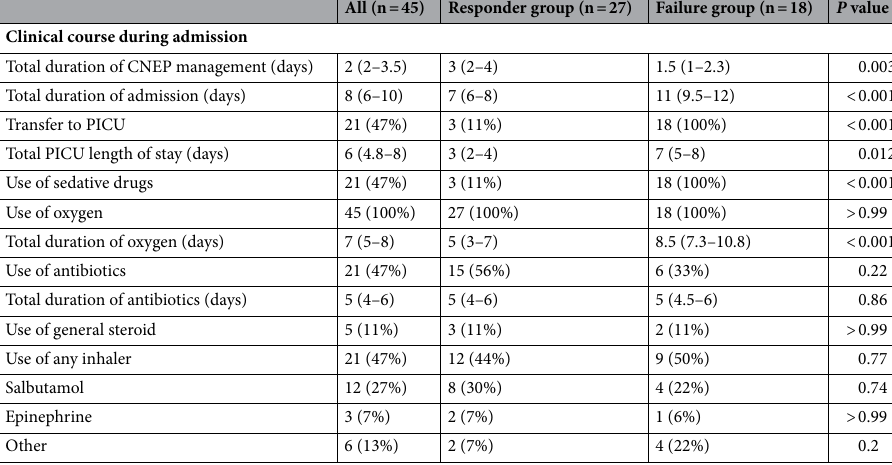
Table 3. Comparison of clinical course between responder and failure group. CNEP continuous negative extrathoracic pressure, PICU pediatric intensive care unit, Values are median + interquartile ranges.